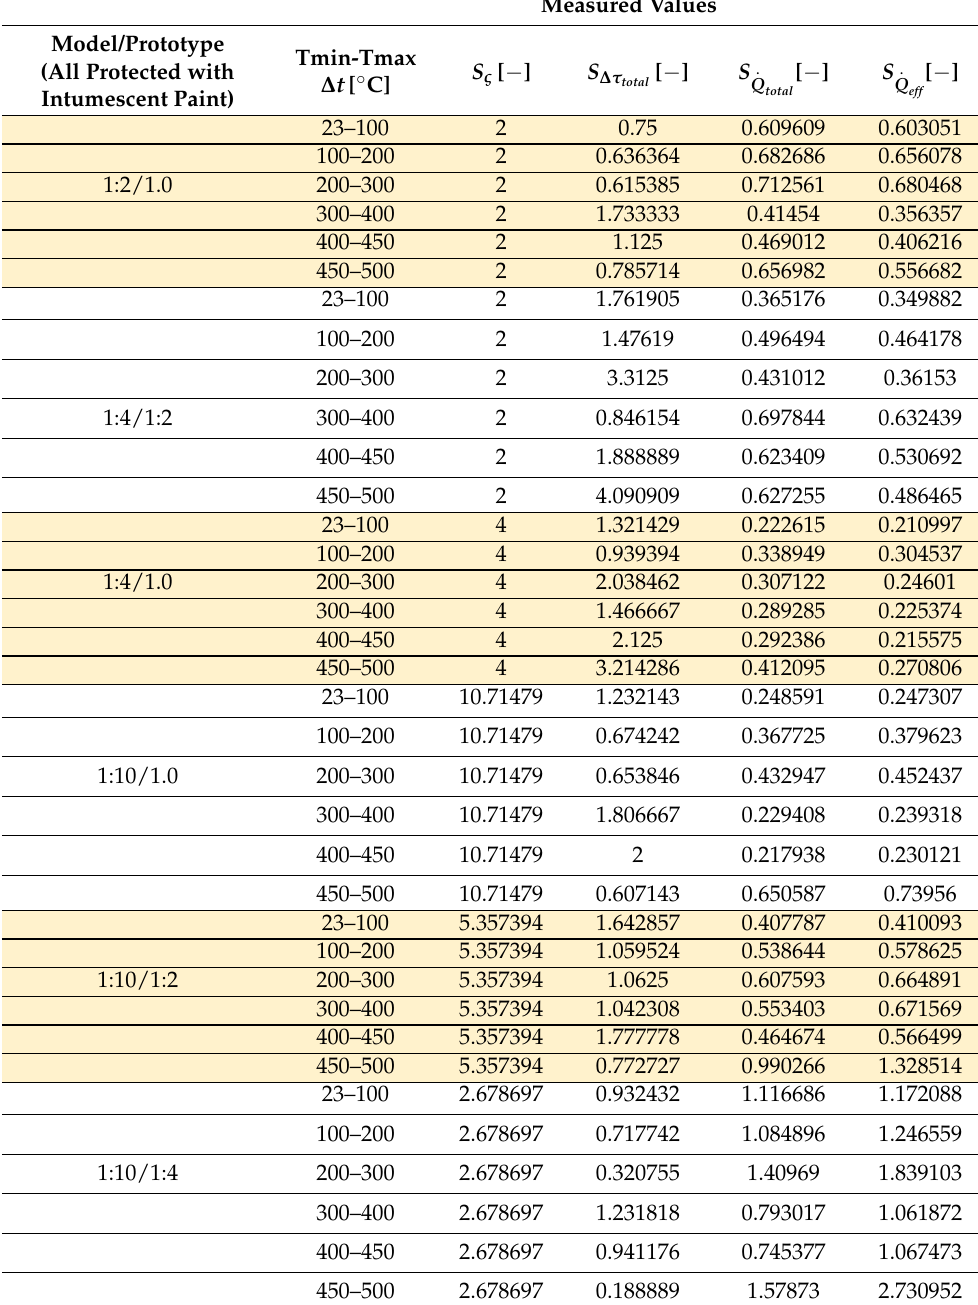
Table 6. Version II. Values obtained using direct